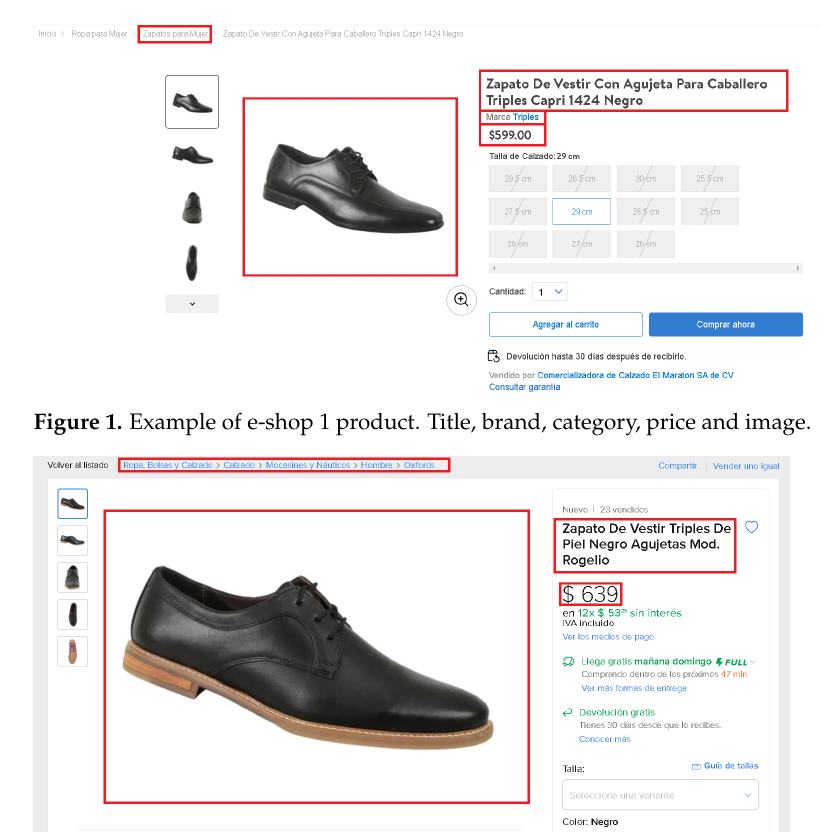
Figure 2. Example of e-shop 2 product. Title, brand, category, price and